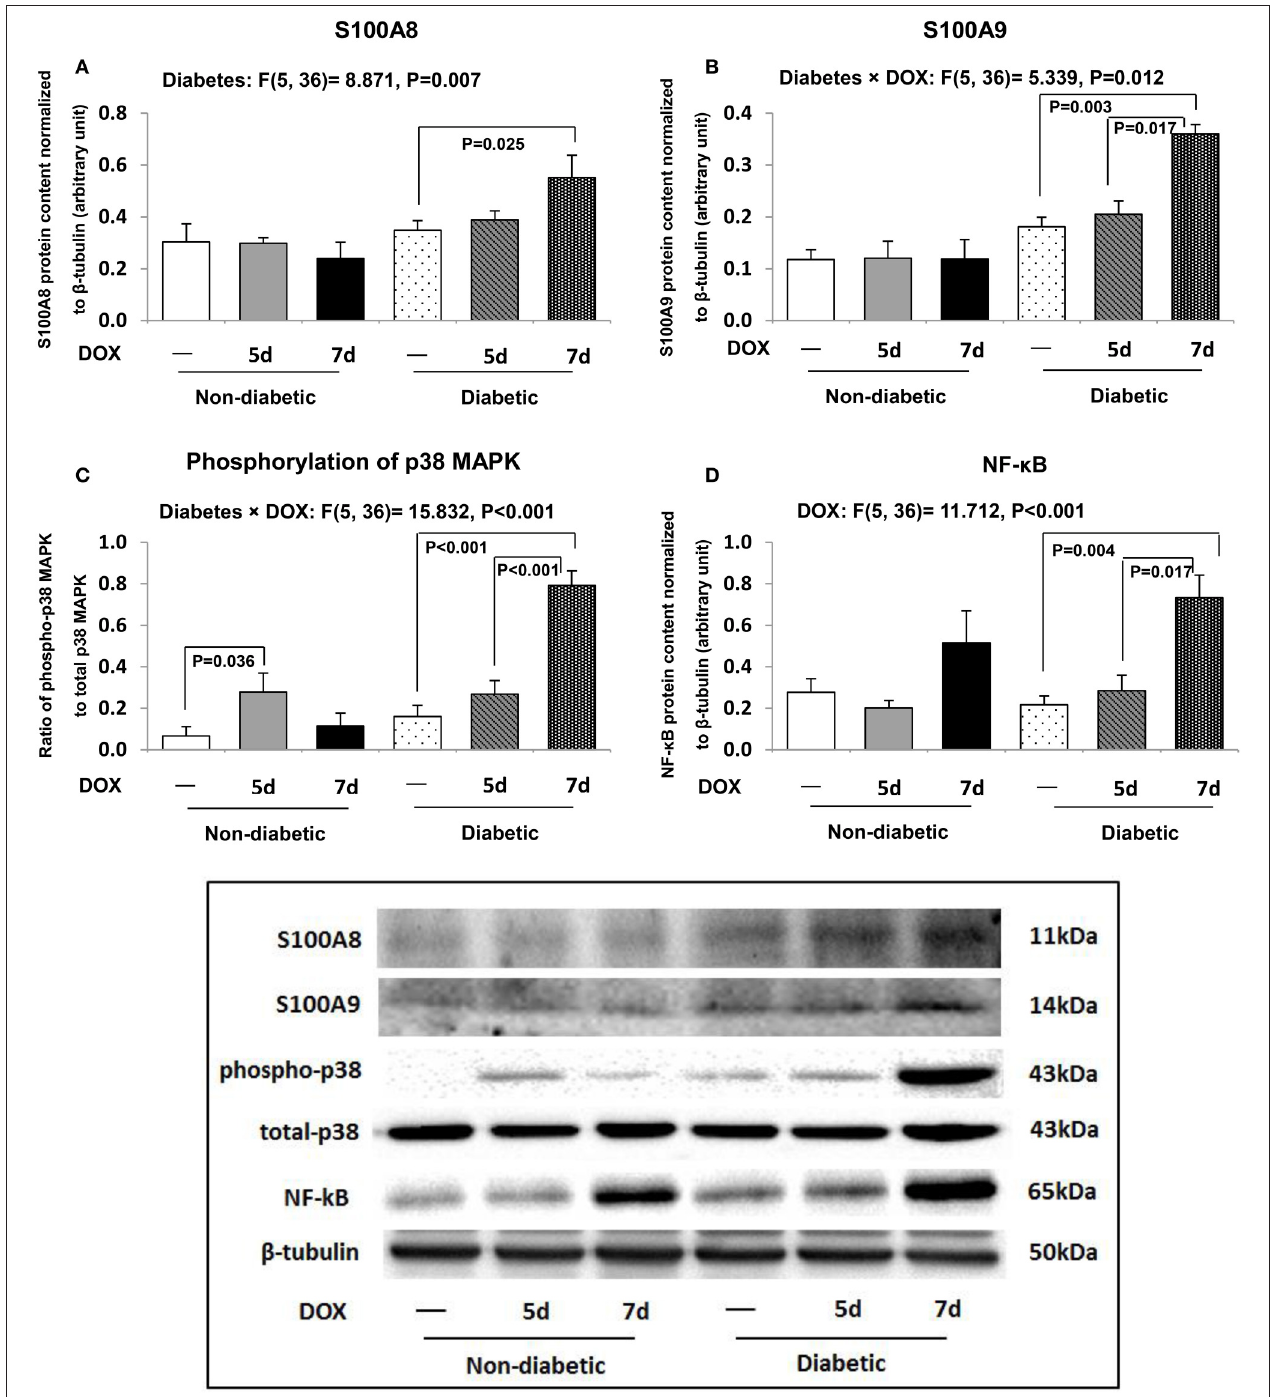
FIGURE 4 | Cardiac inflammatory pathway. The protein abundances of S100A8 (A) , S100A9 (B) , phospho-p38, total p38 (C) , and NF- κ B (D) in the hearts were examined by Western blot. Densitometric quantification was performed and data are presented as net intensity x resulting band area and expressed in arbitrary units. Results are normalized to corresponding β -tubulin signal. Data are expressed as mean ± SEM. According to our two-way ANOVA results, a significant interaction effect between the two experimental factors (i.e., diabetes and DOX treatment) was found in S100A9 ( P = 0.012, F = 5.339; B ) and phosphorylation of p38 MAPK ( P < 0.001, F = 15.832; C ). A significant main effect of the factor diabetes was found in S100A8 ( P = 0.007, F = 8.871; A ). A significant main effect of the factor DOX treatment was found in NF- κ B ( P < 0.001, F = 11.712; D ). Individual means were compared among groups by one-way ANOVA with Turkey’s HSD post-hoc test.